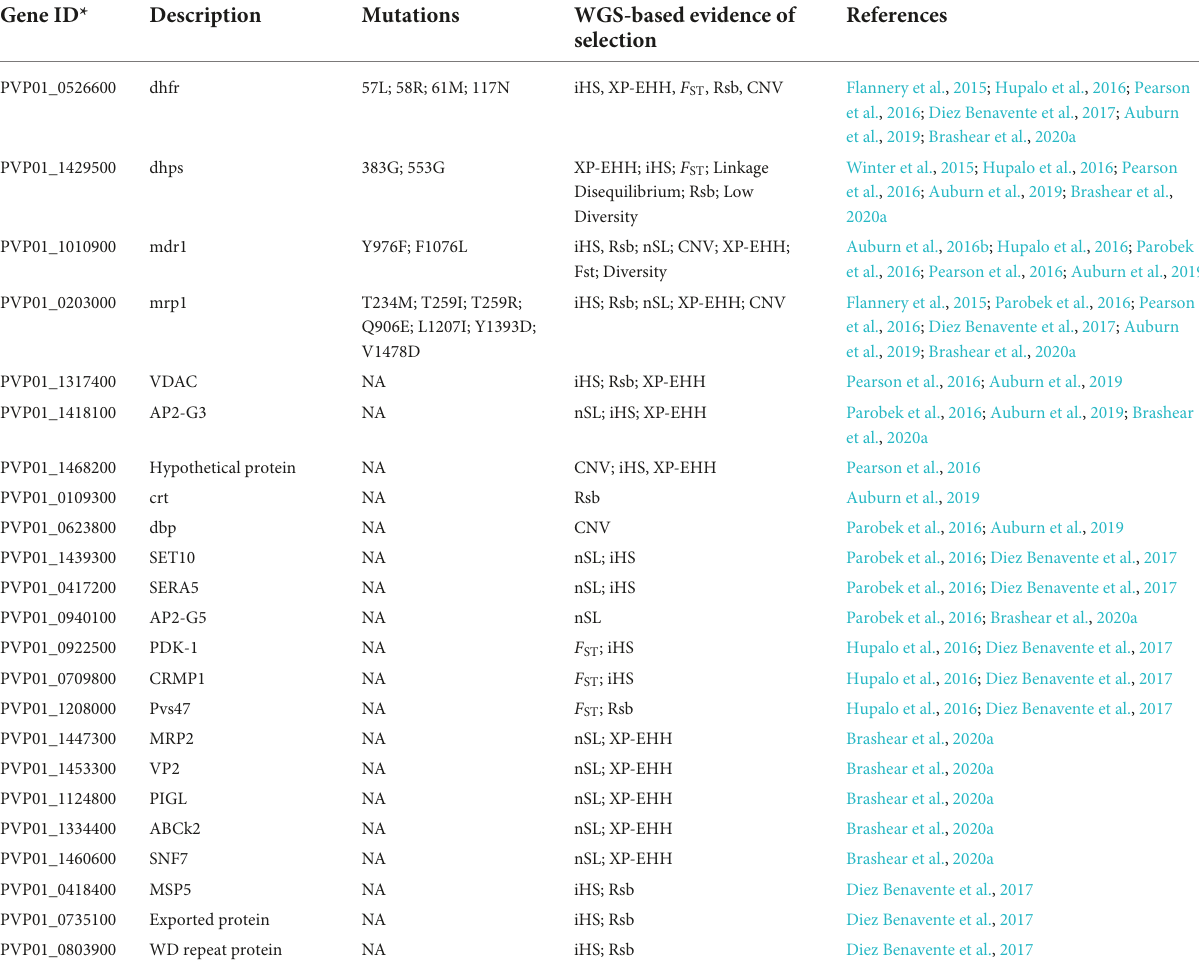
TABLE 1 Genes implicated as being under directional selection from population genomics